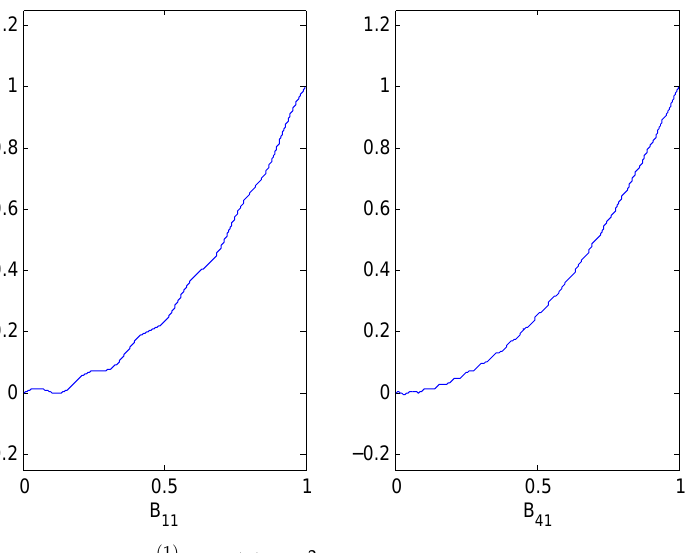
Figure 2. Berrut B